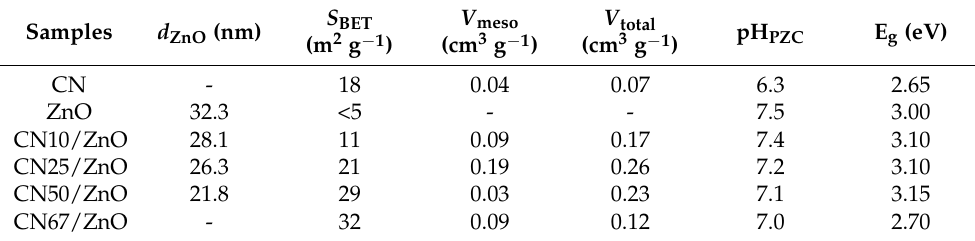
Table 1. Textural, chemical, and optical properties of pure CN, pristine ZnO, and CN/ZnO composites.